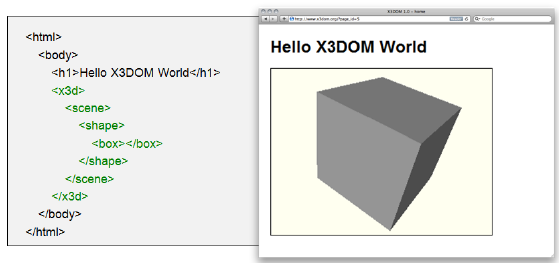
Figure 3. Simple example showing how the 3D content is declaratively embedded into an HTML page using